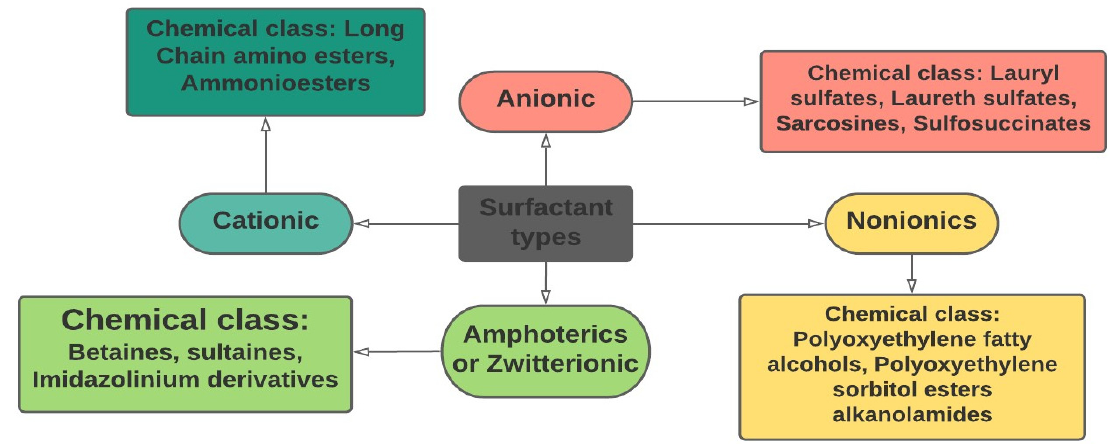
Figure 4. ( A – G ) The structure of surfactin; and ( G ) the types of surfactant.